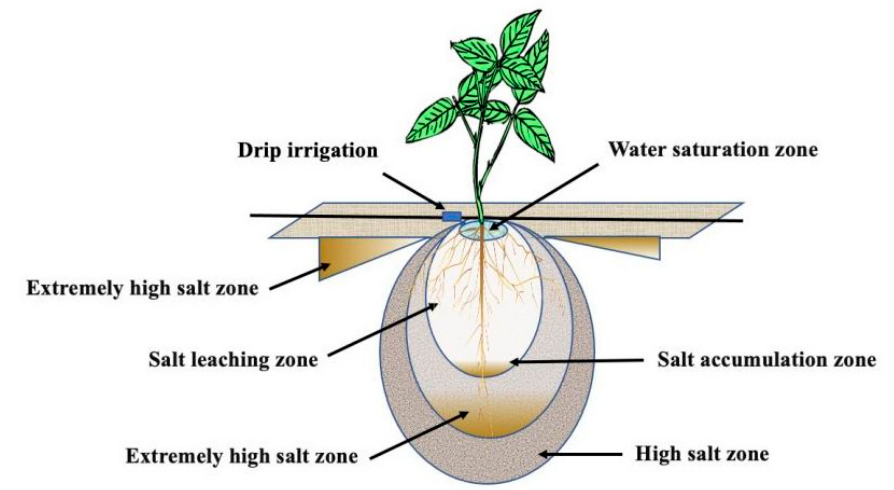
Figure 1. Soil salinity accumulation status under long-term drip irrigation.